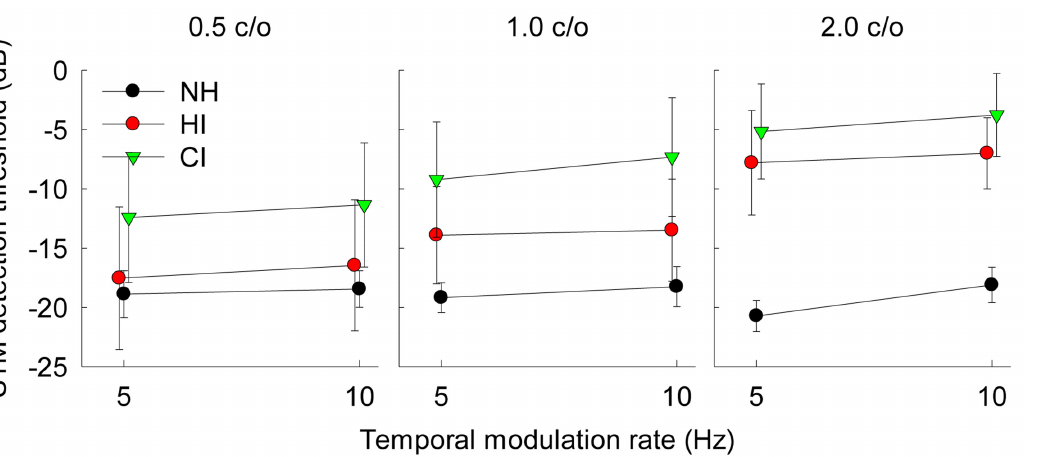
Fig 4. Mean STM detection thresholds averaged across subjects. Error bars represent one standard deviation across